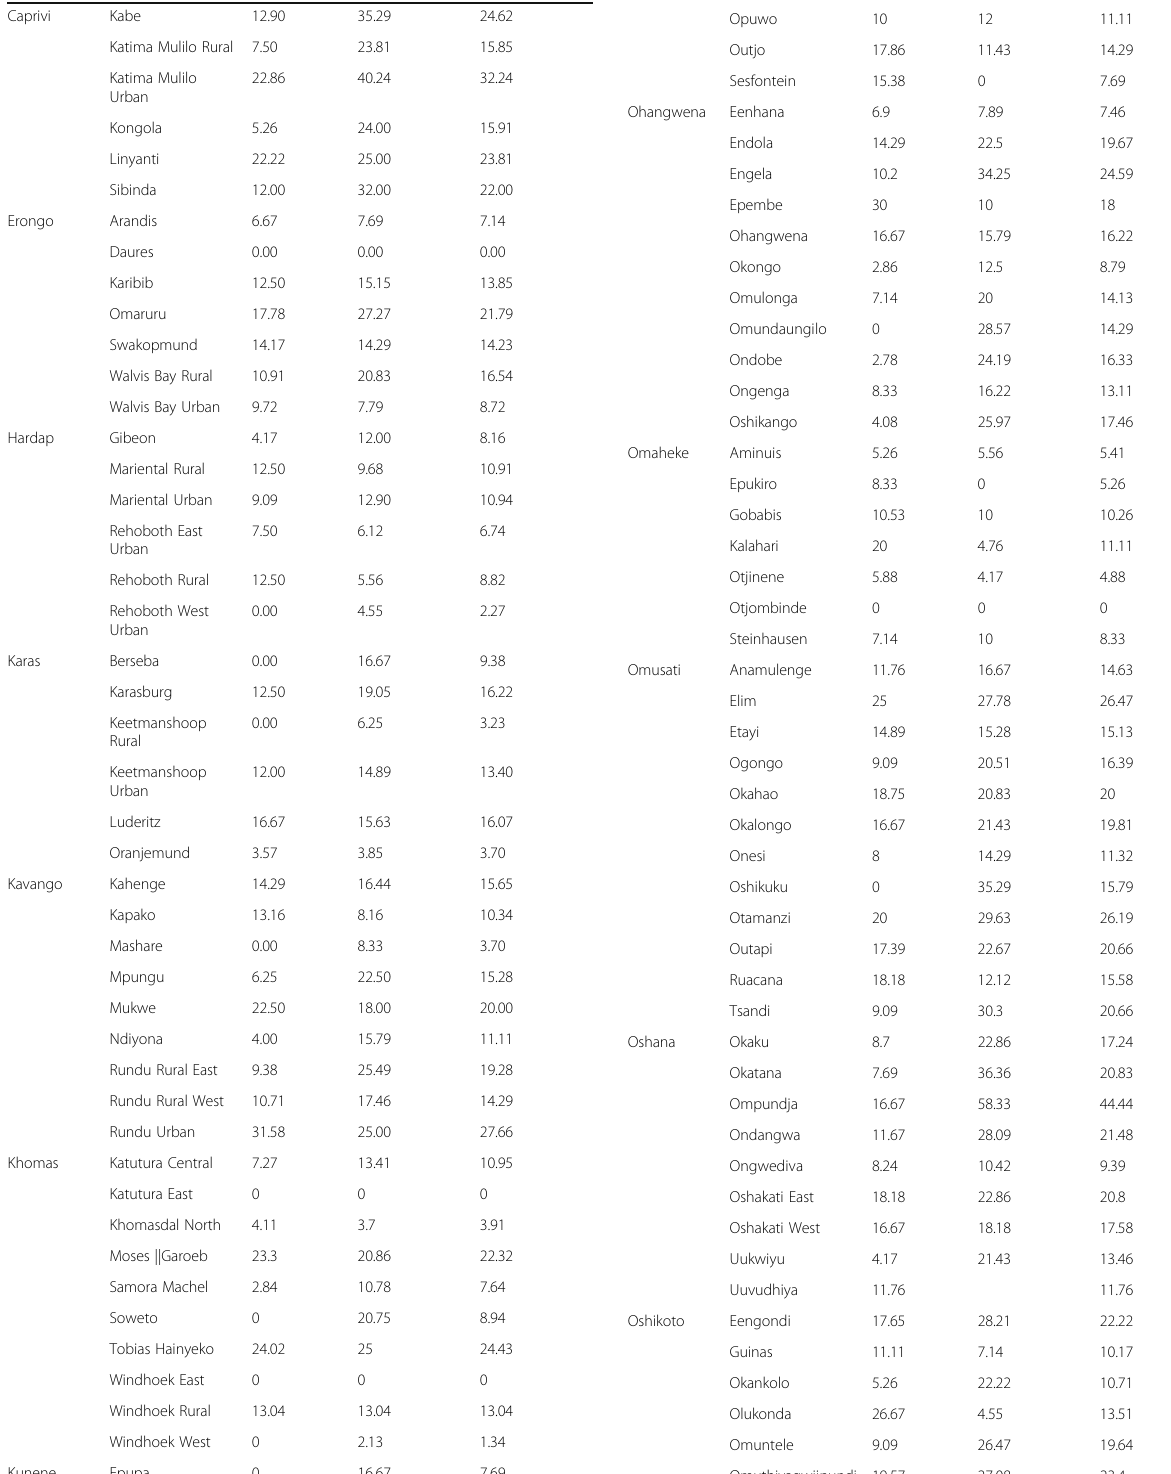
Table 5 Observed HIV prevalence per constituency and per gender Region